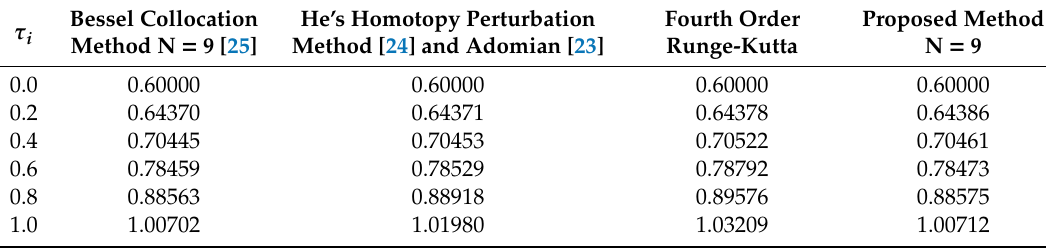
Table 10. Comparison between RC collocation method and other methods for v N ( τ